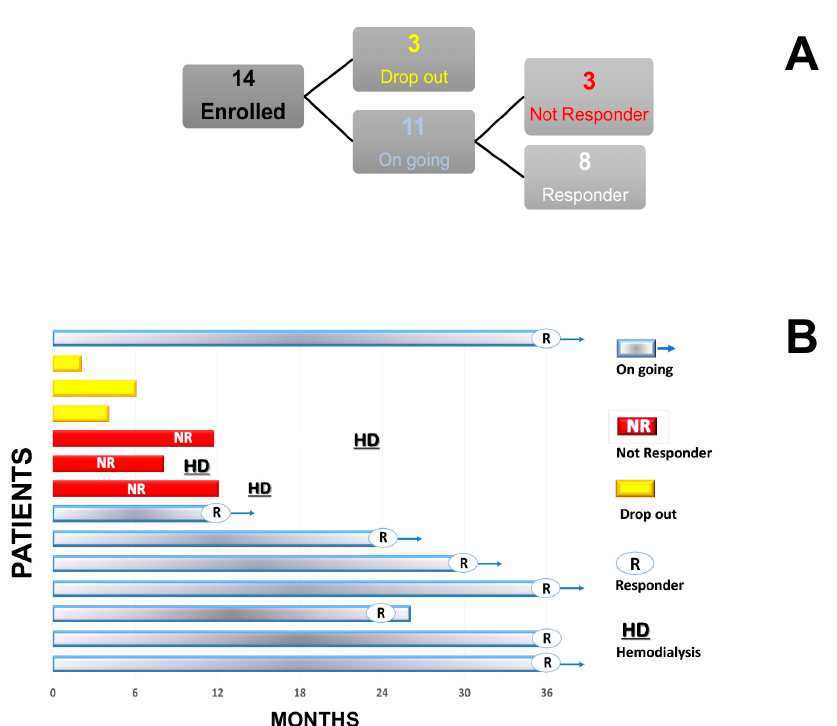
Figure 1. Panel ( A ), flow chart: 14 patients were enrolled, three stopped ECP treatment within 6 months for logistical and/or personal reasons, and one patient stopper after 24 months for his will. Panel ( B ): the clinical outcome of the enrolled patients. R, responder patient; NR, non-responder patient; HD, haemodialysis; Ongoing, patients that continued ECP treatment; Drop out, patients that stopped the ECP treatment.